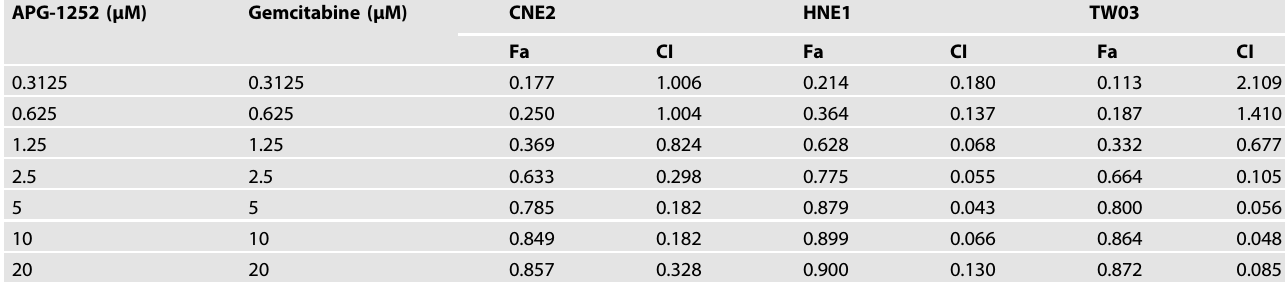
Table 1. The CI calculated using the CalcuSyn